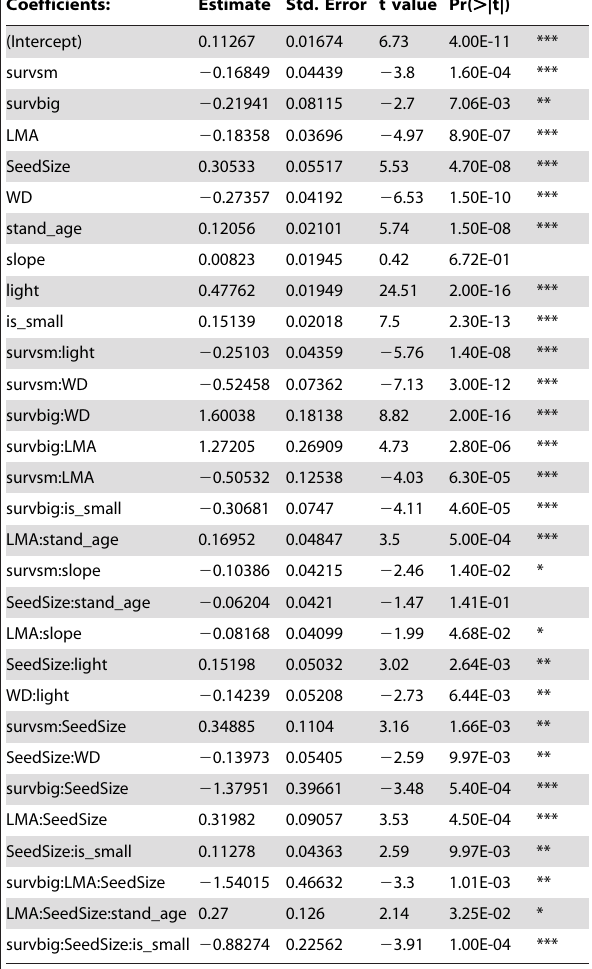
Table 2. Optimal regression model of species growth rates against survival and ontogenetic, environmental, and trait